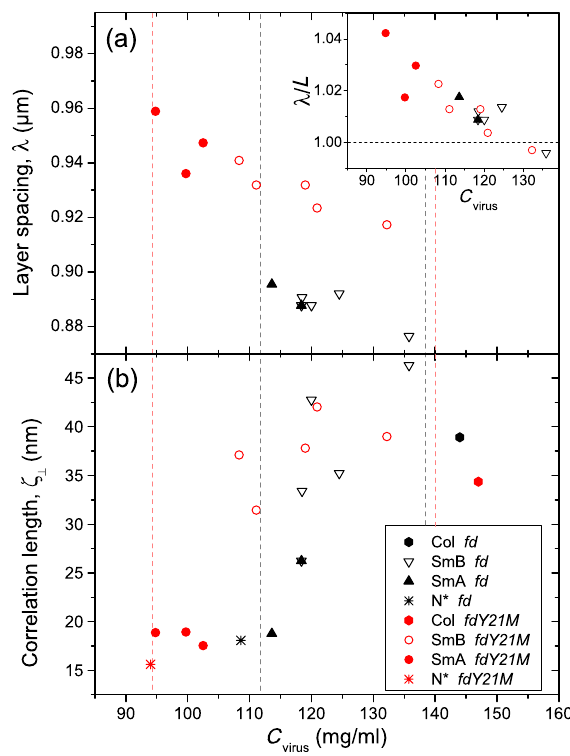
6. (a) Smectic-layer spacing λ obtained by fast Fourier transform of the optical microscopy images [Fig. 5(b)]. Inset: Smectic-layer spacing normalized by the respective viral contour length L . (b) Positional correlation length ζ ⊥ ¼ 2 =FWHM within the smectic layer measured by SAXS on the (100) Bragg reflections [Fig. 5(c)] in the same samples as in (a). Black and red symbols refer to semiflexible fd and stiff fdY21M viral rods, respectively. The dashed lines indicate the smectic range for fd (gray) and fdY21M (red) suspensions ( I s ¼ 20